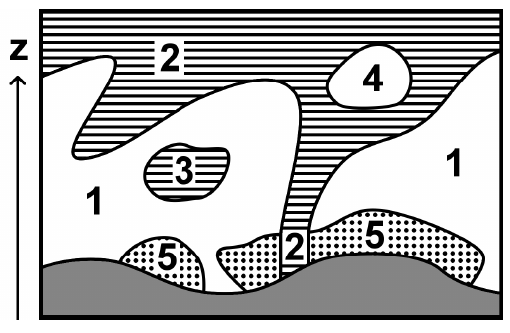
Fig. 1. The 3-D labelling algorithm assigns labels from 1 to 5 to ev- ery grid point based on PV, 2 , and the “connectivity” to the top of the ERA-Interim data set or the surface. The labels used are as follows: 1, troposphere; 2, stratosphere; 3, stratospheric cut-off in the troposphere or other cyclonic PV anomaly not connected to the stratosphere; 4, tropospheric cut-off in the stratosphere; and 5, surface-bound PV anomaly. In the special cases where label 2 merges with label 5, the label 2 is attributed to grid points in the vertical column below the area of contact. The label 2 can only propagate horizontally if the contact occurs in the upper half of the troposphere (in this vertical column). See Sect. 2.2 for a more de- tailed description of this